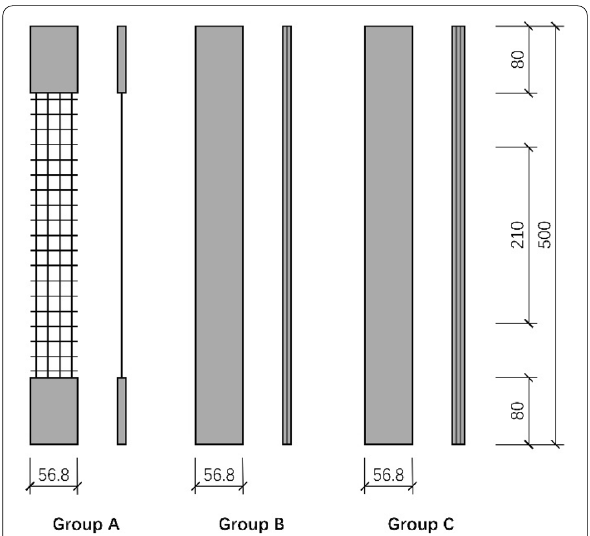
Fig. 4 Geometry of direct tensile test specimens [dimensions in